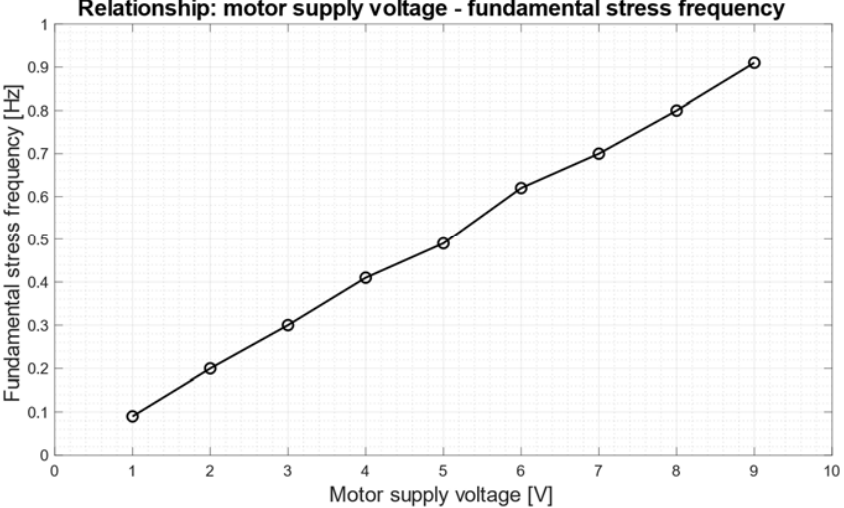
Figure 9. Relationship between the motor supply voltage and the fundamental frequency of the sine wave generated by the axial motion of piston A.